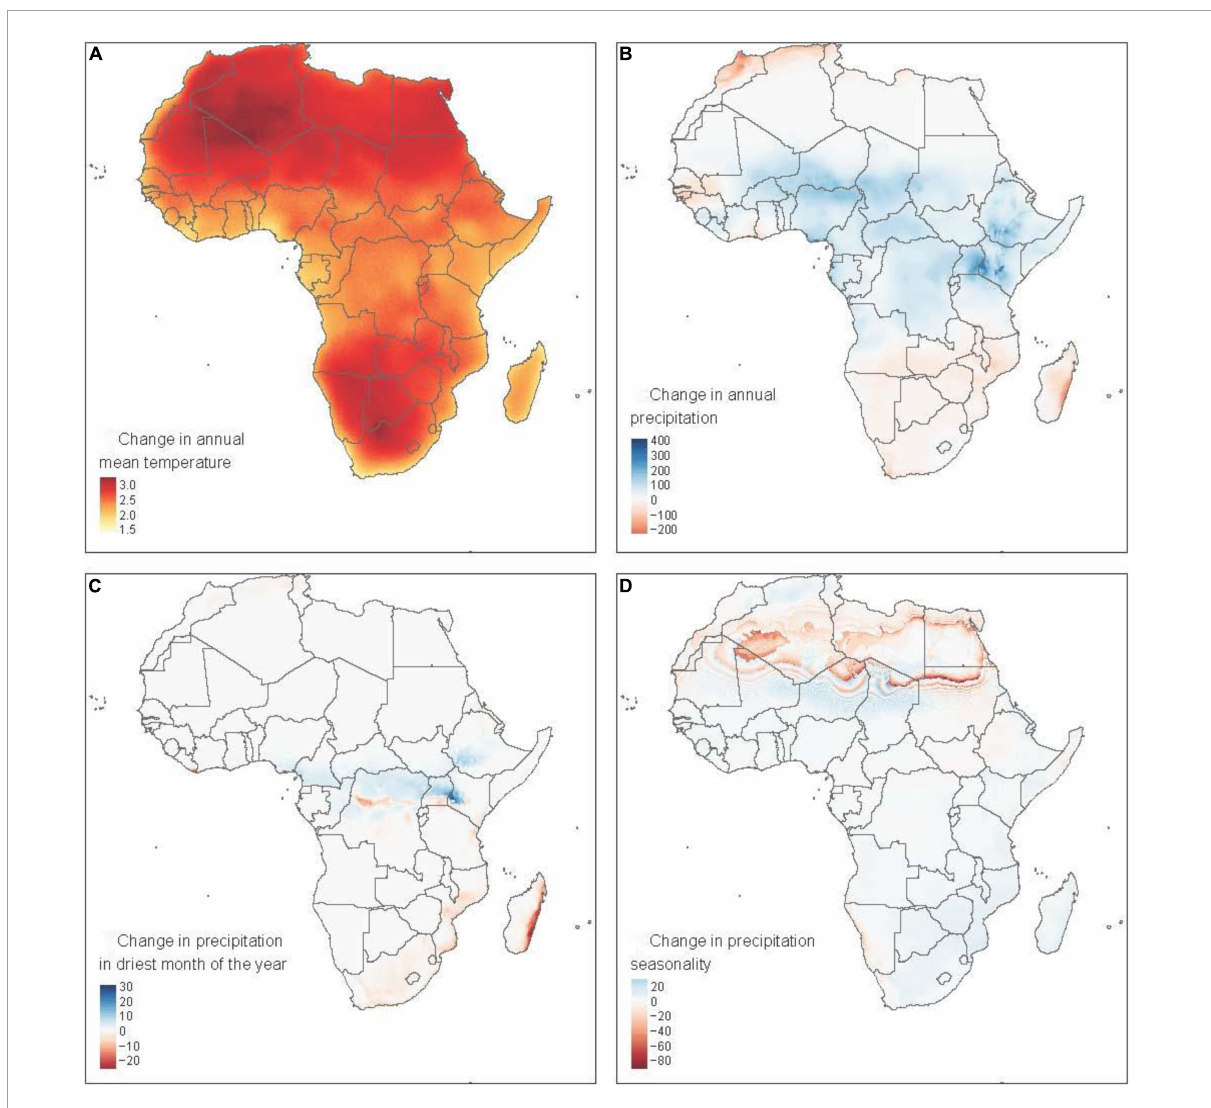
FIGURE4 Predicted patterns of changes between the reference period 1966–1990 and the CMIP5 predictions for the period 2060–2079 in annual mean temperature (A) , annual precipitation (B) , precipitation in the driest month of the year (C) , and seasonality of precipitation as assessed by the coefficient of variation of monthly values (D) across the African continents (all data from worldclim.org). Note there are many uncertainties with these estimates as they do not account for the land-cover effects, which are increasingly recognized as important (Sheil,